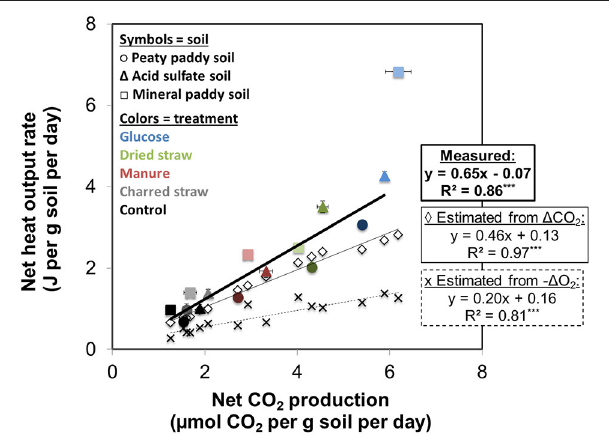
FIGURE 2 | Average respiration rate ( µ mol CO 2 per g soil per day) during 5 days of incubation, plotted against the average heat output rate (J per g soil per day) for the same period. Soils are represented by different symbols and shades (light (cid:3) = mineral paddy soil, medium 1 = acid sulfate soil, dark ◦ = peaty paddy soil) and the colors correspond to treatments: Control, black; CS, gray; M, red; DS, green; Gluc, blue. Error bars denote standard error of the mean of the duplicates. Open diamonds show the predicted heat dissipation (Equation 1) if all CO 2 had been produced from aerobic respiration (assuming no-growth). Crosses show predicted heat output from aerobic respiration based on O 2 -consumption and the oxycaloric equivalent (455 kJ mol − 1 O 2 ) plotted against measured CO 2 -production. Lines indicate regression fits (with equations and R 2 - values given in the figure) for calculated aerobic respiration heat output (thin solid line and dashed line for CO 2 -based and O 2 -based calculations, respectively) and measured respiration and heat output (thick solid line), excluding the glucose treatment in the mineral paddy soil.